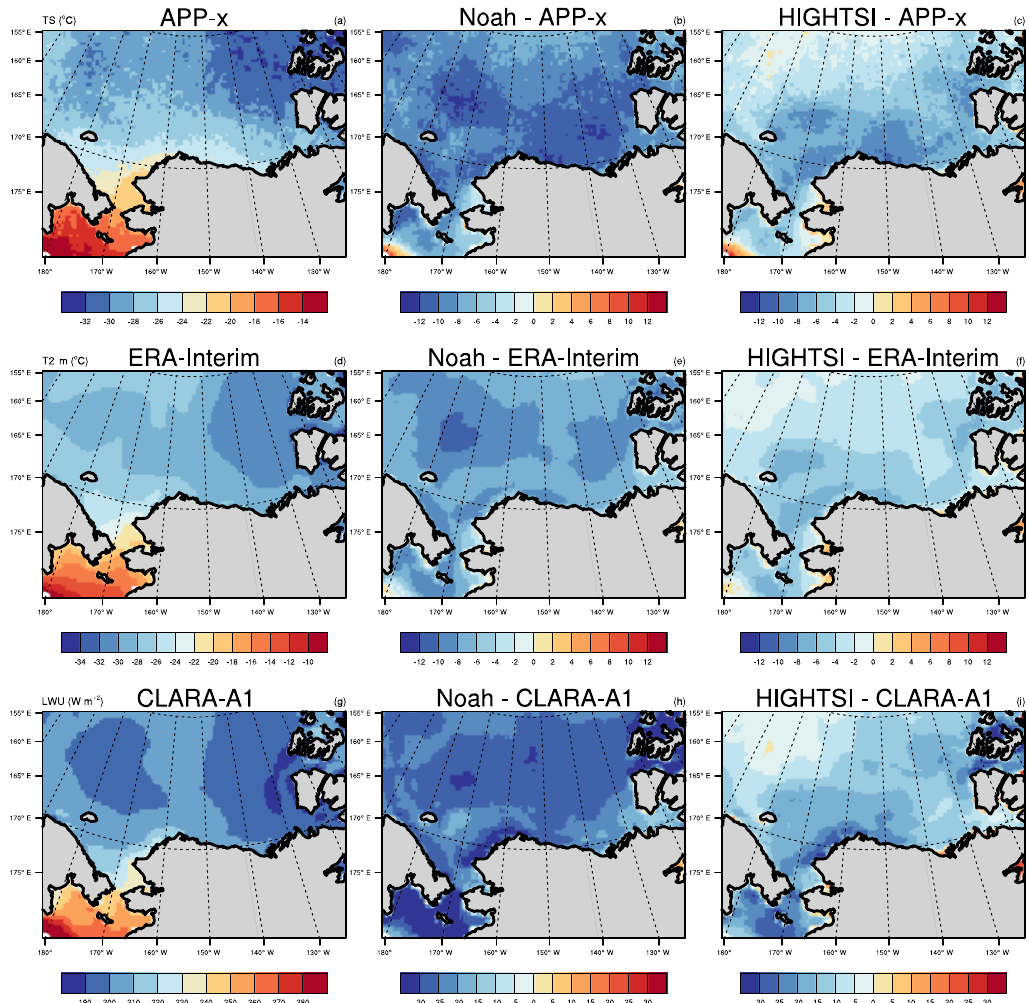
Figure 5. Surface temperature, 2m air temperature and surface upward long-wave radiation over sea ice surface in January 1998: observations and bias in Noah and